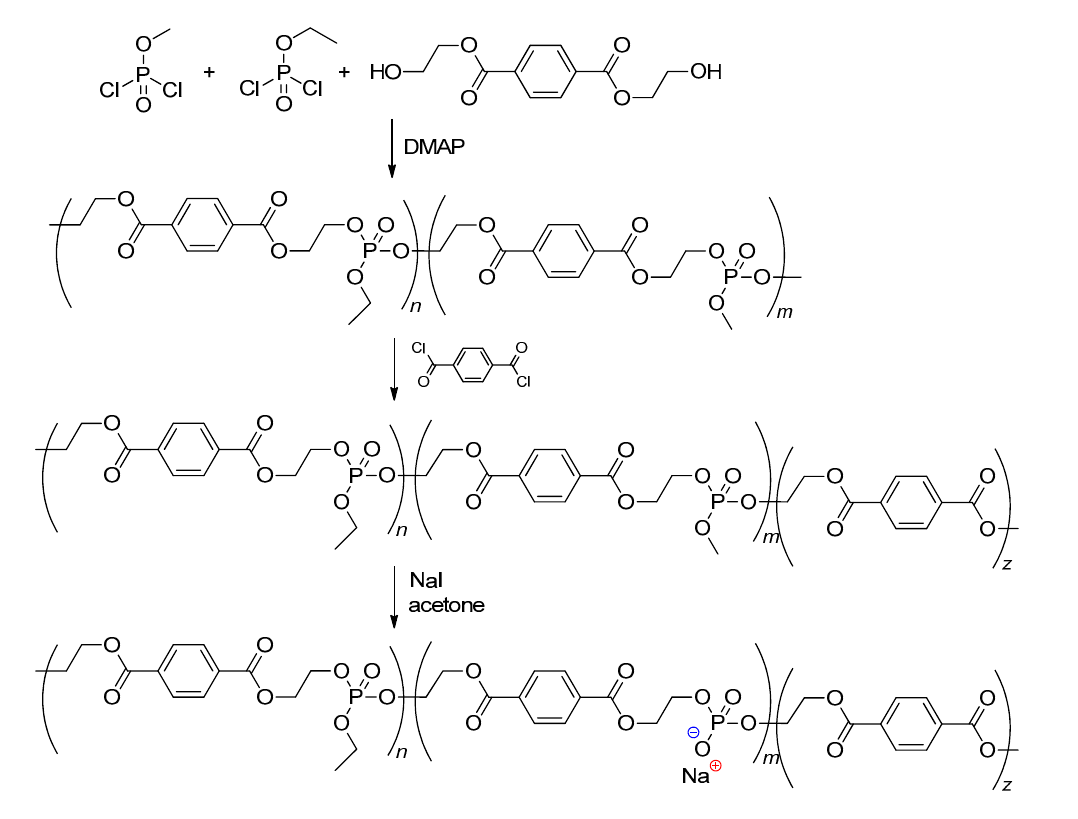
Scheme 4. Synthesis of the phosphate-containing analog of PET